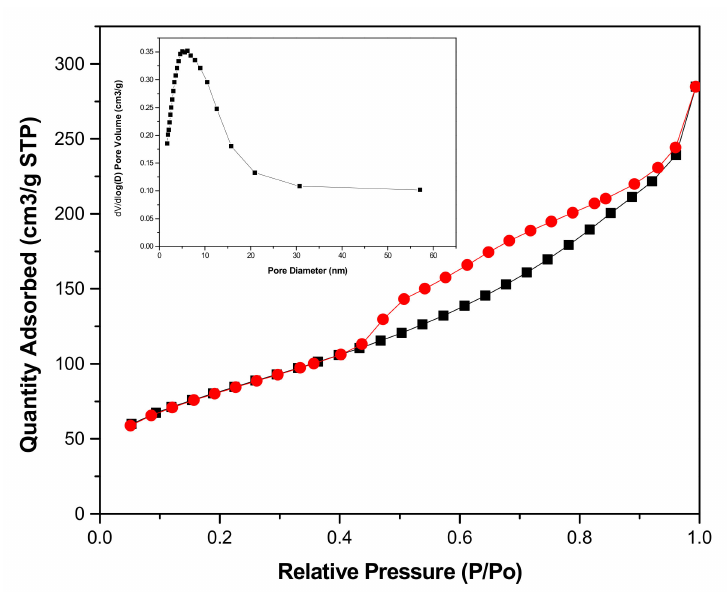
Figure 5. N 2 adsorption-desorption isotherm curves of the TiO 2 sample with 10 h reaction time and the inset showing its pore size